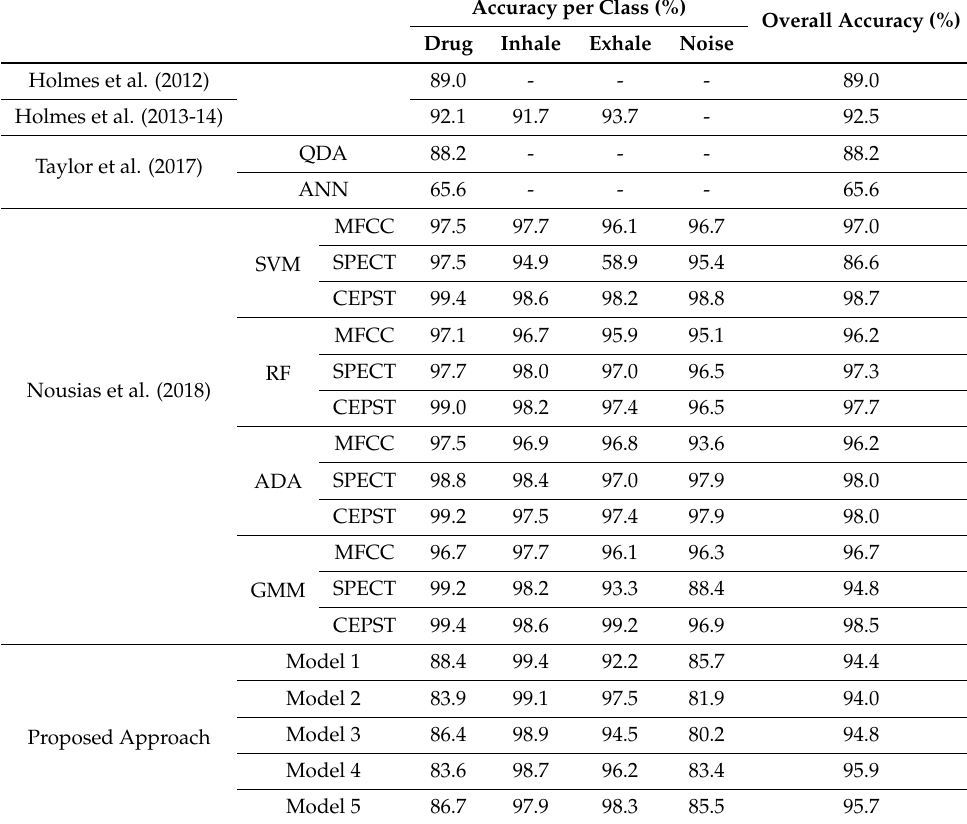
Table 2. State of the Art with multi-subject validation setting.